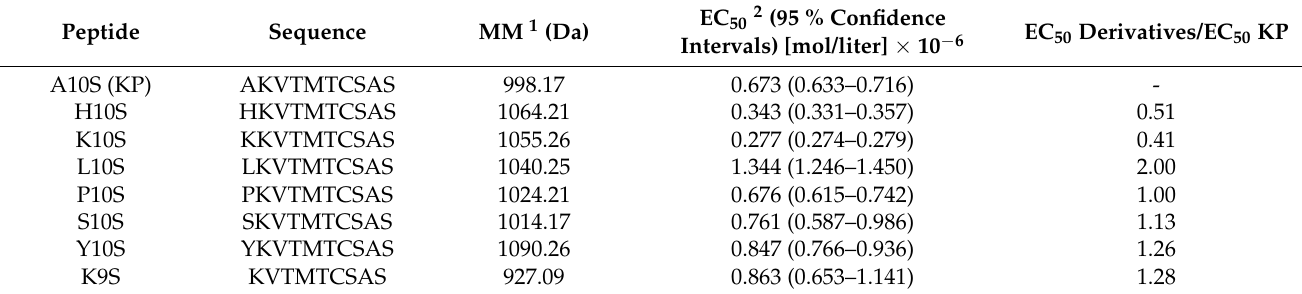
Table 1. In vitro fungicidal activity of KP and its derivatives against Candida albicans